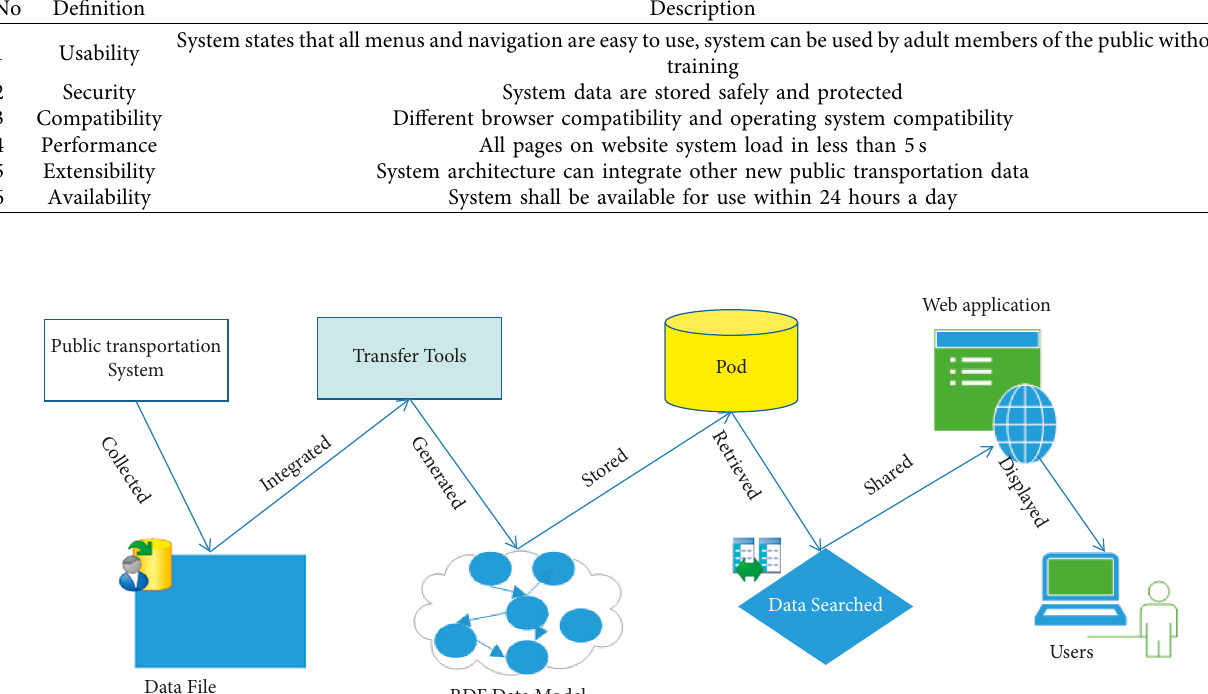
Figure 2: Data processing